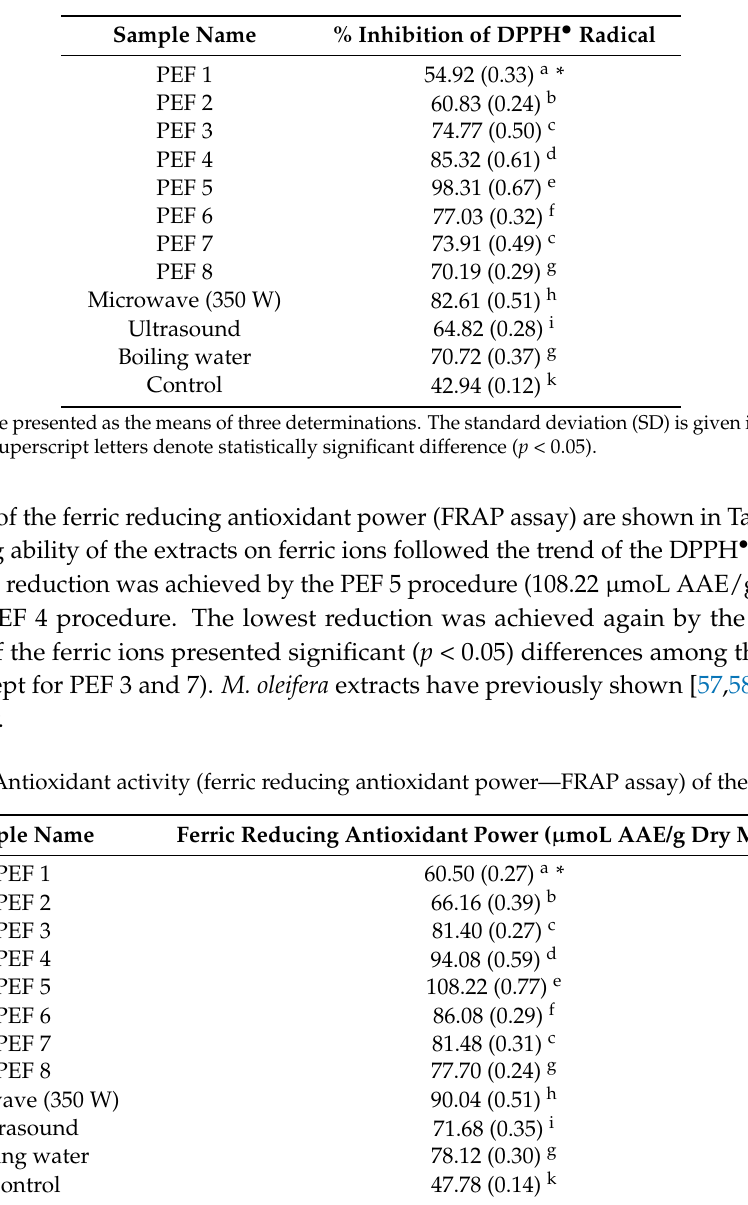
Table 3. Antioxidant activity (% inhibition of the DPPH • radical) of the extracts.